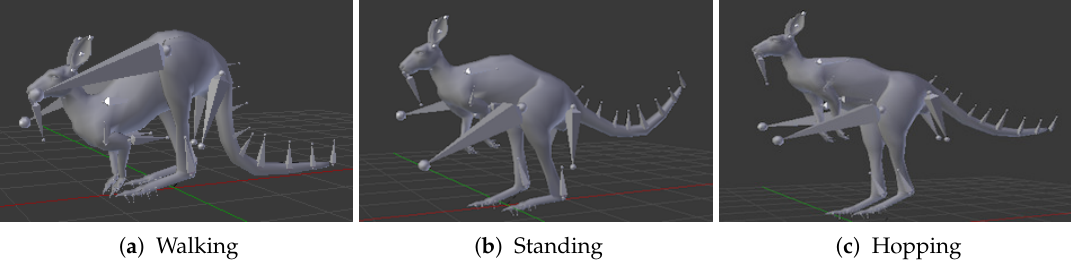
Figure 1. The three MoCap activities used for the generated kangaroo dataset mapped on a kangaroo